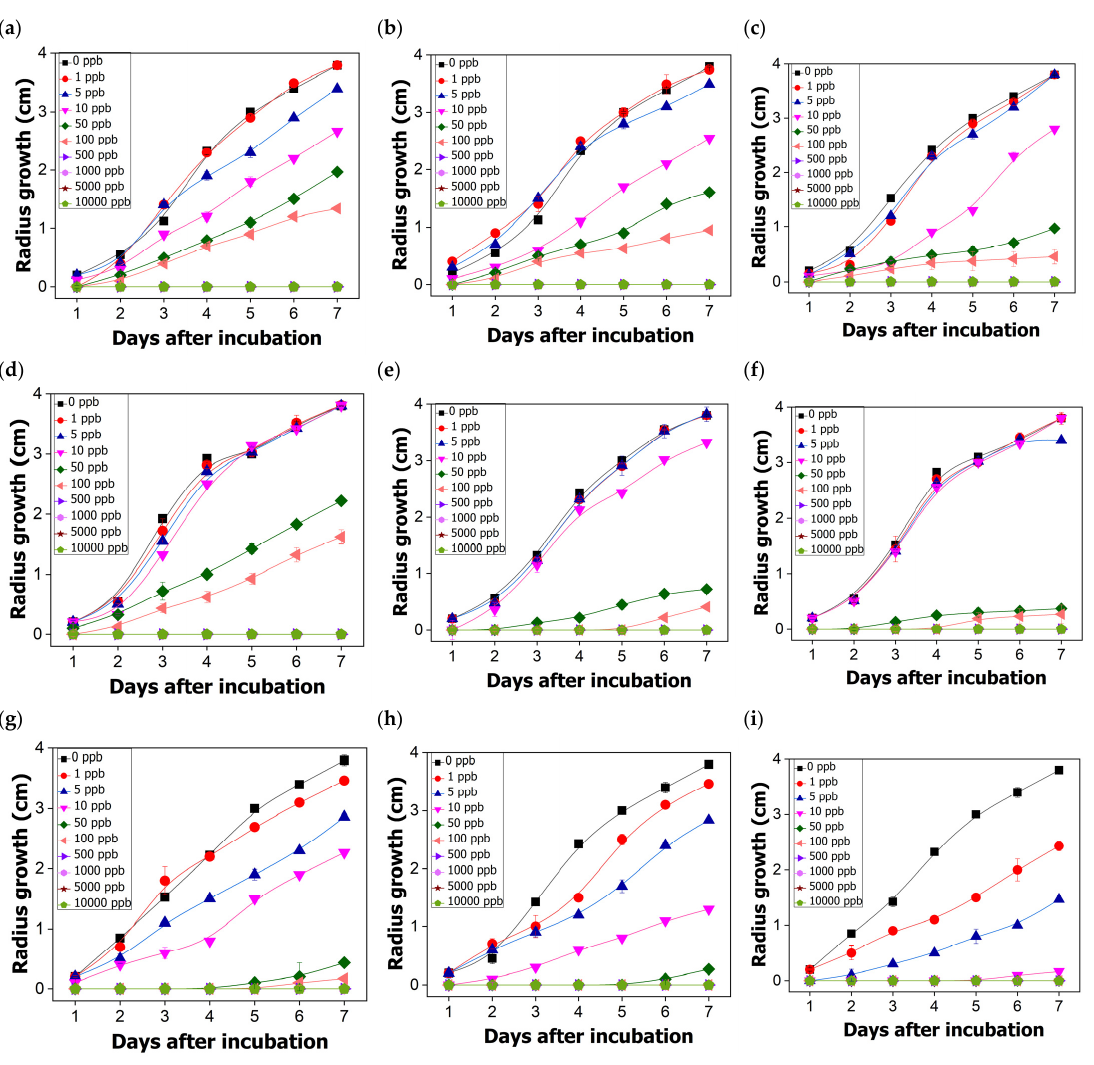
Figure 8. Growth curves of G. boninense treated for 7 days with HMBS-1 ( a ), HMBS-2 ( b ), HMBS-4 ( c ), HMDS-1 ( d ), HMDS-2 ( e ), HMDS-4 ( f ) and HMT-6 ( g ), HMT-8 ( h ) and HMT-10 ( i ).